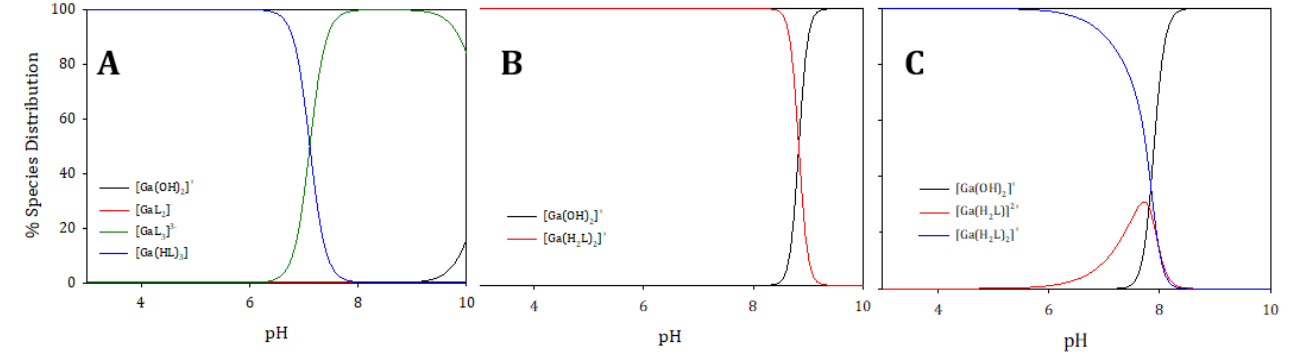
Figure 11. Species distribution curves for 1 (panel A ), 4 (panel B ) and 7 (panel C ) at 25 °C (L total = 10 μ M; Ga 3+total = 1 μ M). The data were calculated based on the log β values reported in Table 3. their steric hindrance, are unable to form metal complexes with a smaller M:L molar ratio and show lower K values. This decreased affinity for the metal ion is highlighted by the